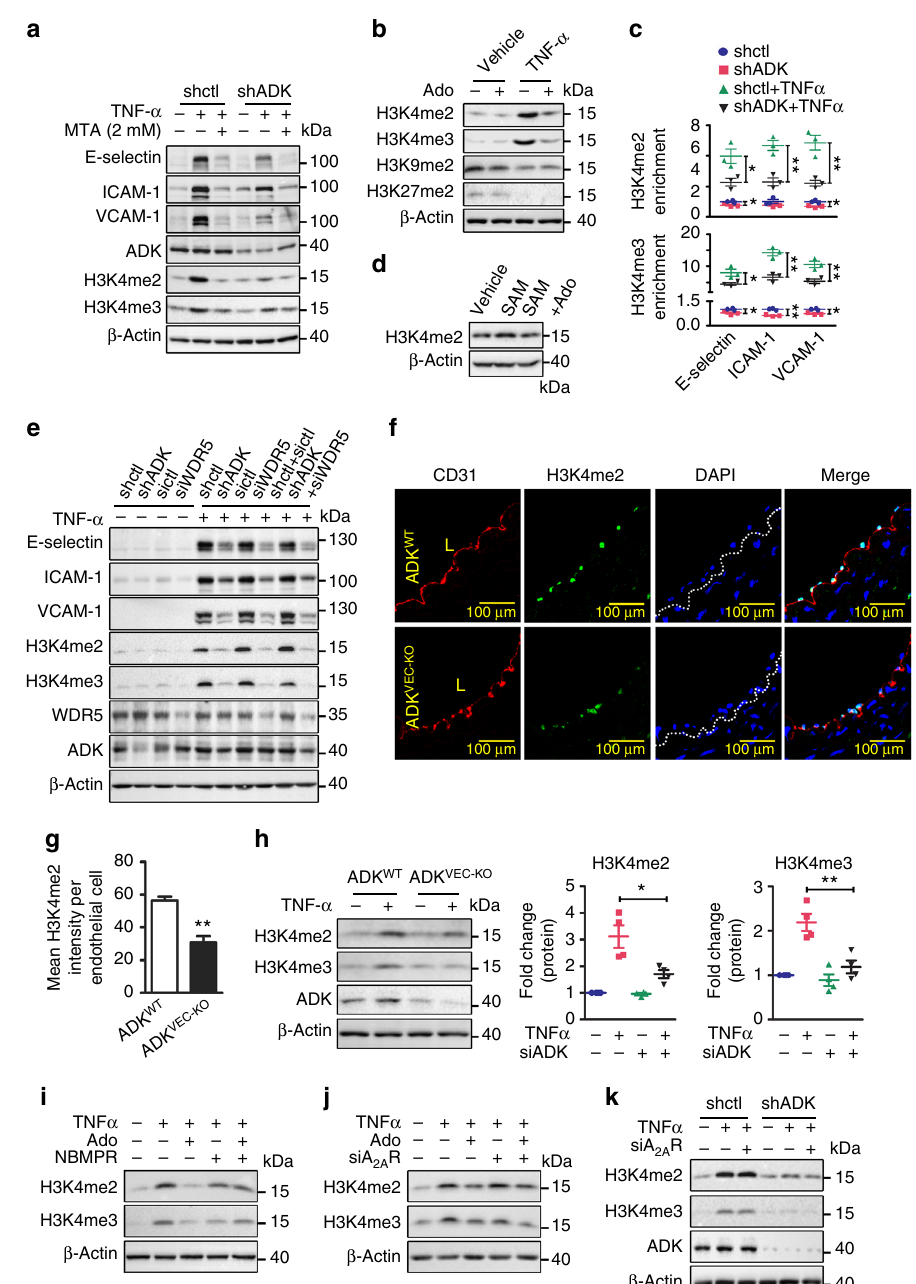
Fig. 4 Intracellular adenosine decreases the methylation level of H3K4. a Western blot detection of adhesion molecules and H3K4 methylation in TNF- α (10 ng/ml for 4 h)-treated ADK KD or Ctrl HUVECs pretreated with 2 mM MTA for 30 min ( n = 4). b Western blot detection of methylation levels of H3K4, H3K9, and H3K27 in TNF- α (10 ng/ml for 12 h)-treated HUVECs pretreated with 100 µ M adenosine for 30 min ( n = 5). c ChIP assay showing H3K4 methylation on promoters of adhesion molecules in TNF- α (10 ng/ml for 4 h)-treated ADK KD or Ctrl HUVECs ( n = 3). d Western blot detection of H3K4me2 in HUVEC whole-protein lysate supplemented with 1 mg/ml SAM or SAM together with 10 µ M adenosine for 60 min ( n = 4). e Western blot detection of adhesion molecules and H3K4 methylation in TNF- α (10 ng/ml for 4 h)-treated ADK KD or Ctrl HUVECs transiently transfected with control or WDR5 siRNA ( n = 3). f Immuno fl uorescent ( IF ) staining of H3K4me2 on aortic endothelium (areas indicated with CD31 staining, red ) from TNF- α -treated ADK WT and ADK VEC-KO mice. L indicates luminal area of aorta ( scale bar , 100 µ m). g Quanti fi cation of H3K4me2 on aortic endothelium from TNF- α -treated ADK WT and ADK VEC-KO mice ( n = 5 mice per group). h Western blot detection and densitometric quanti fi cation of H3K4 methylation in TNF- α (10 ng/ml for 4 h)-treated MAECs isolated from ADK WT and ADK VEC-KO mice ( n = 4). i Western blot detection of H3K4 methylation in HUVECs. HUVECs, pretreated for 30 min with 10 µ M NBMPR, were incubated with 100 µ M adenosine for 30 min and then stimulated with TNF- α at 10 ng/ml for 4 h ( n = 3). j Western blot detection of H3K4 methylation in TNF- α (10 ng/ml for 4 h)-treated A 2A R KD or Ctrl HUVECs pretreated with 100 µ M adenosine for 30 min ( n = 4). k Western blot detection of H3K4 methylation in TNF- α (10 ng/ml for 4 h)-treated ADK KD or Ctrl HUVECs transiently transfected with control or A 2A R siRNA ( n = 4). For all bar graphs , data are the mean ± SEM, * P < 0.05 and ** P < 0.01 (unpaired, two-tailed Student ’ s t -test)